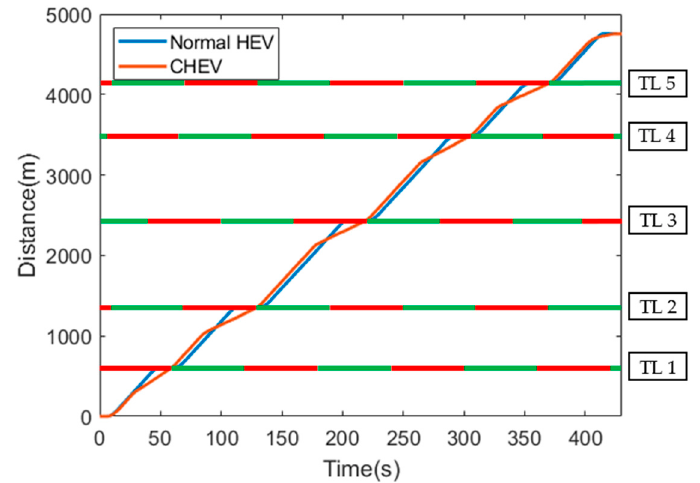
Figure 10. Distance with traffic light information.